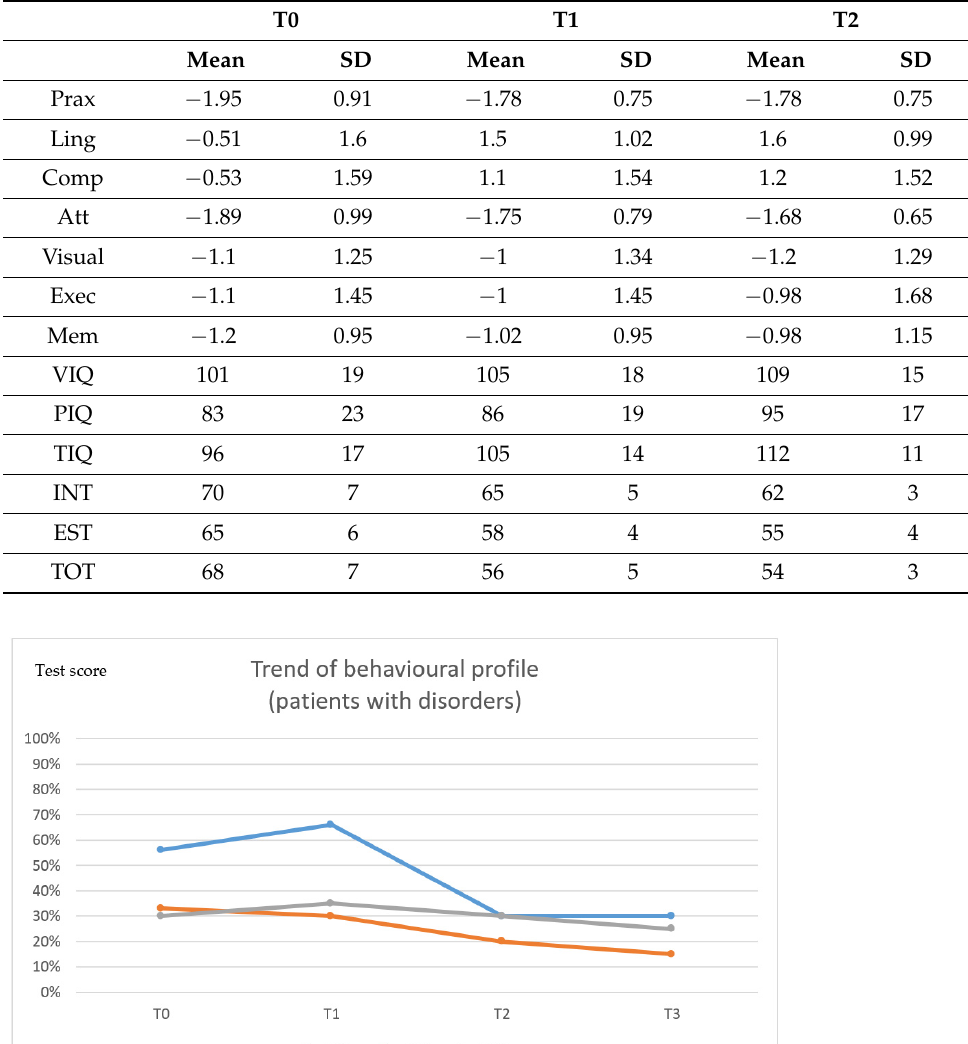
Table 2. Mean values and standard deviations.